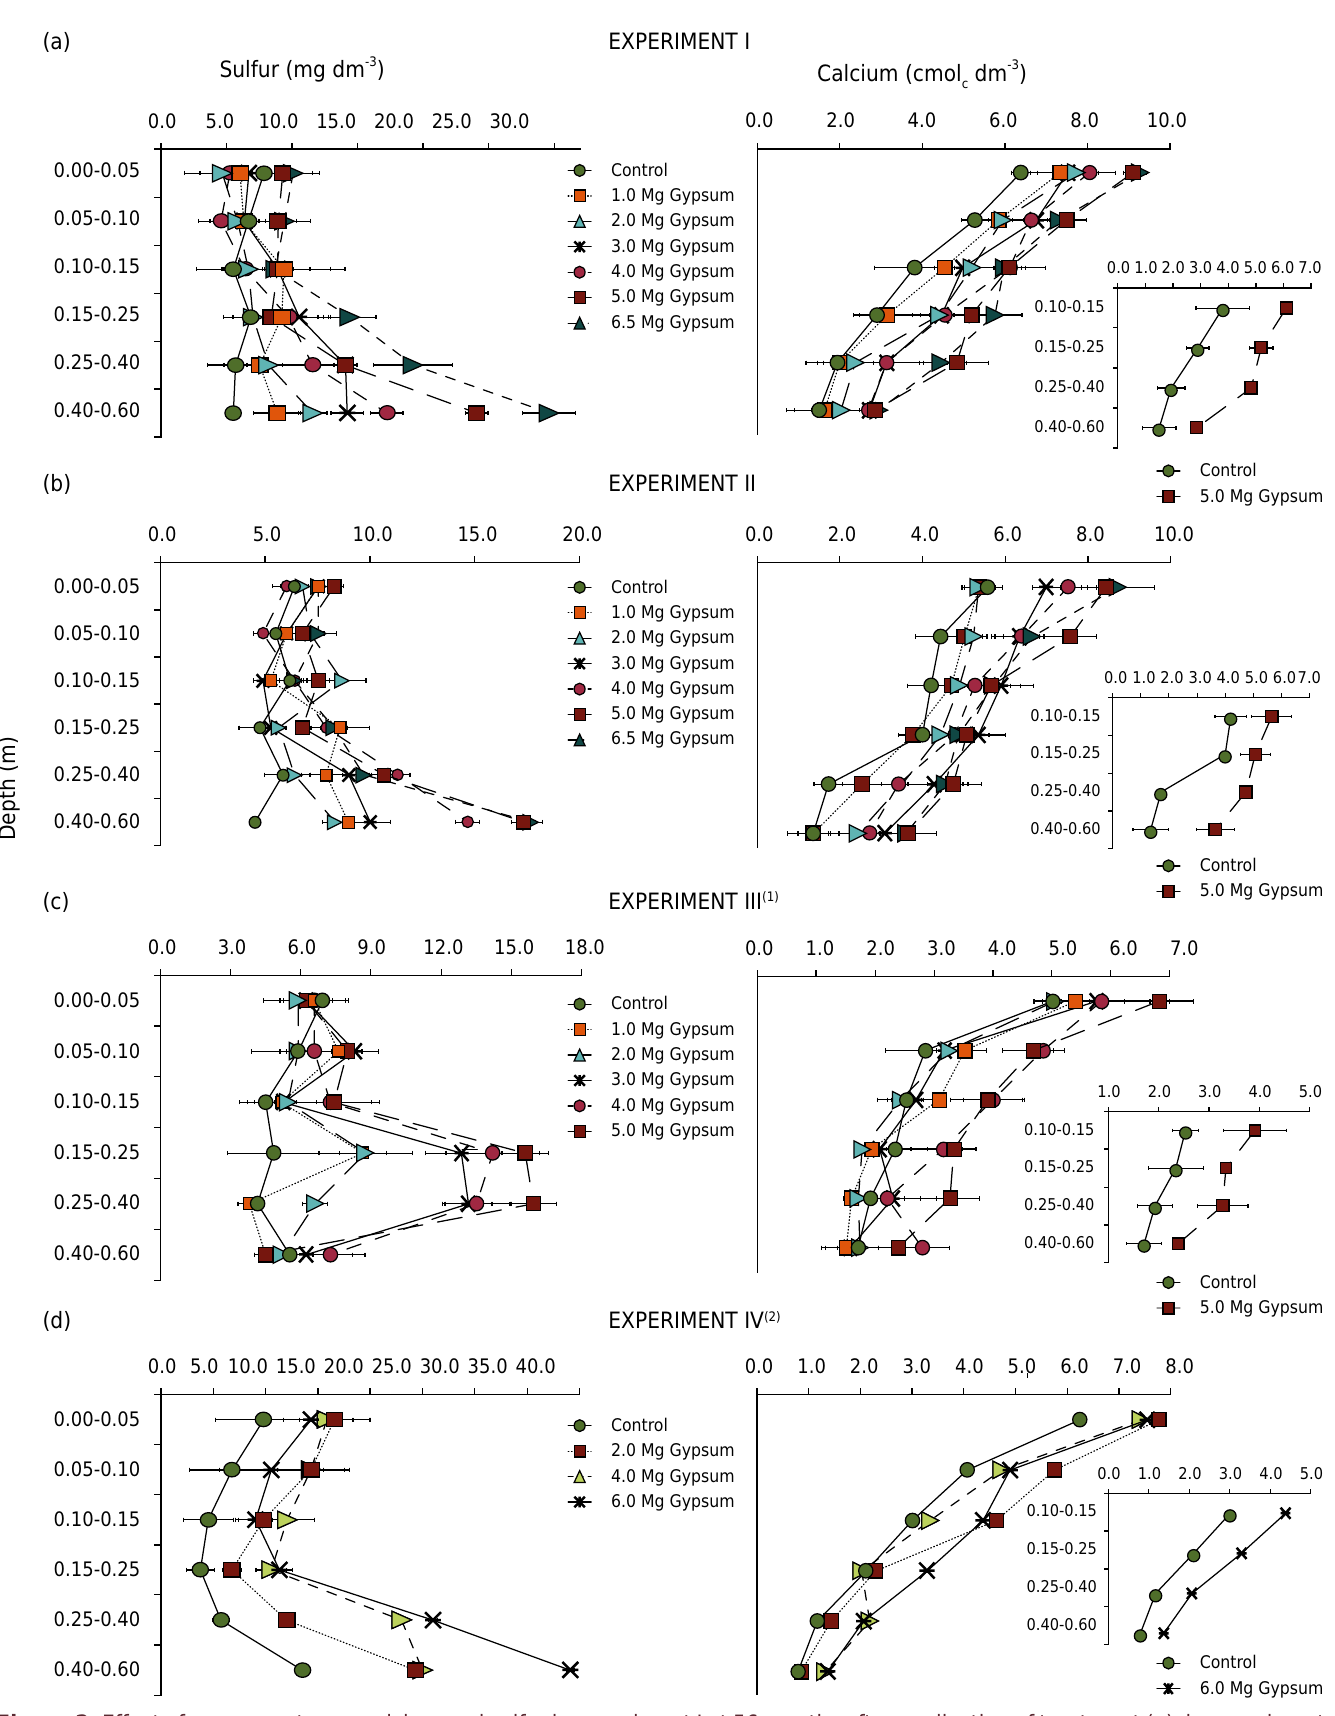
Figure 2. Effect of gypsum rates on calcium and sulfur in experiment I at 56 months after application of treatment (a), in experiment II at 56 months (b), in experiment III at 30 months (c), and experiment IV at 30 months (d). (1) Average of sulfur and calcium among treatments with lime, and the treatments that did not receive inputs due to the significant interaction between rates of gypsum and lime. (2) Averages of sulfur and calcium for gypsum rates combined with 3.6 Mg ha -1 of lime due to the interaction between rates of gypsum and lime. Error bars represent 95 % confidence limits for the